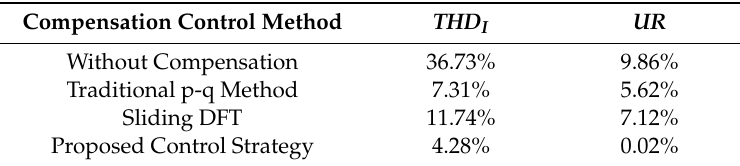
Figure 9. Compensation result with the proposed control strategy for case 1. Table 1. Compensation results for case 1. Table 1. Compensation results for case 1.